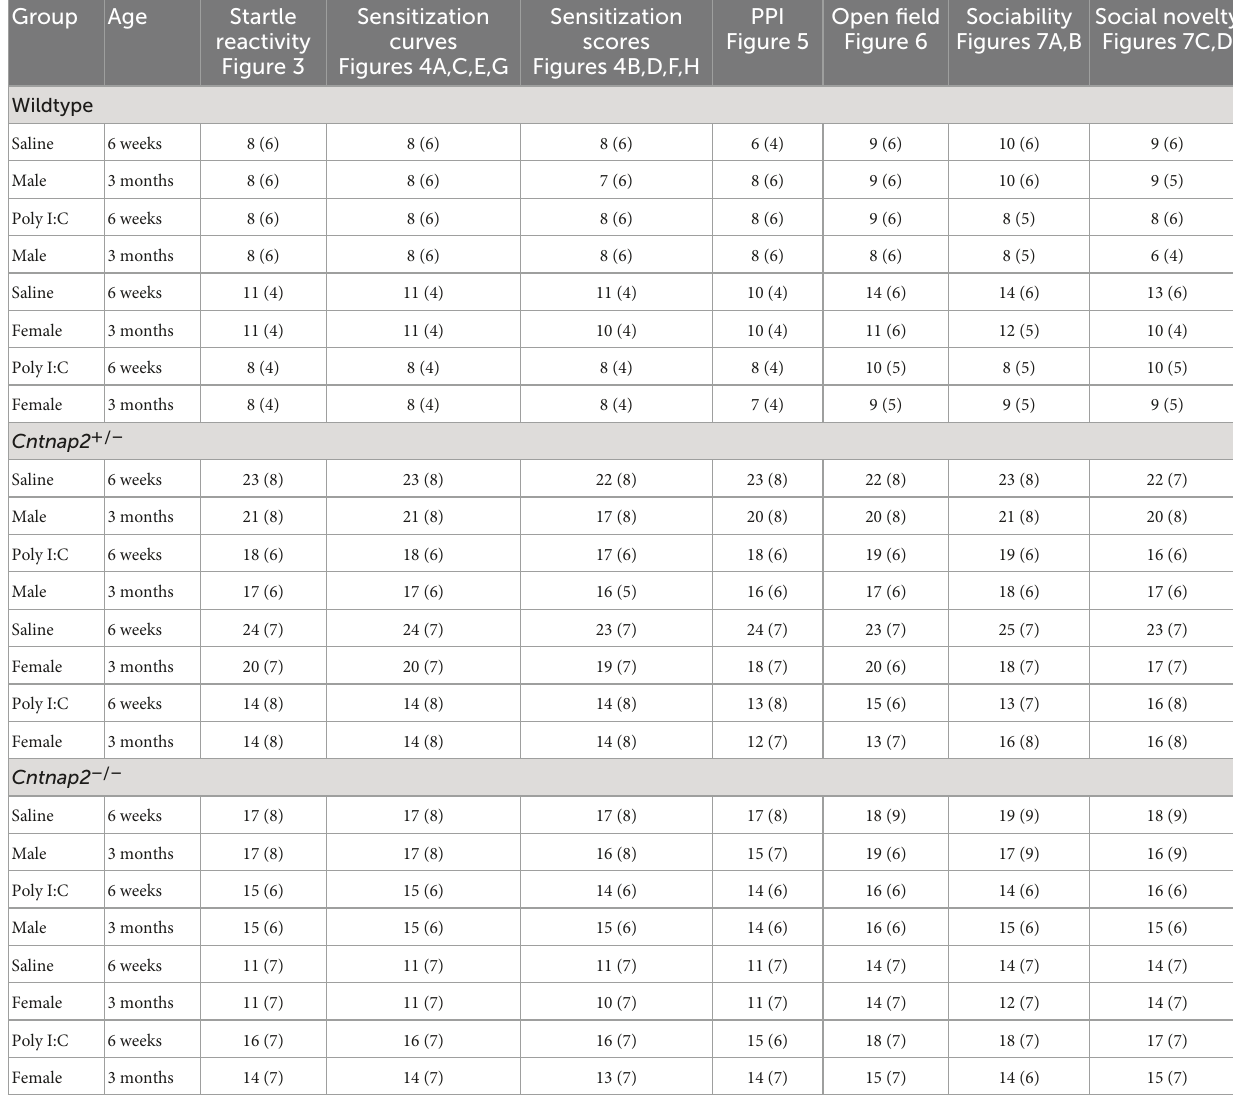
TABLE 1 The number of offspring per group for each behavioral experiment after outlier exclusion. Group Age Startle